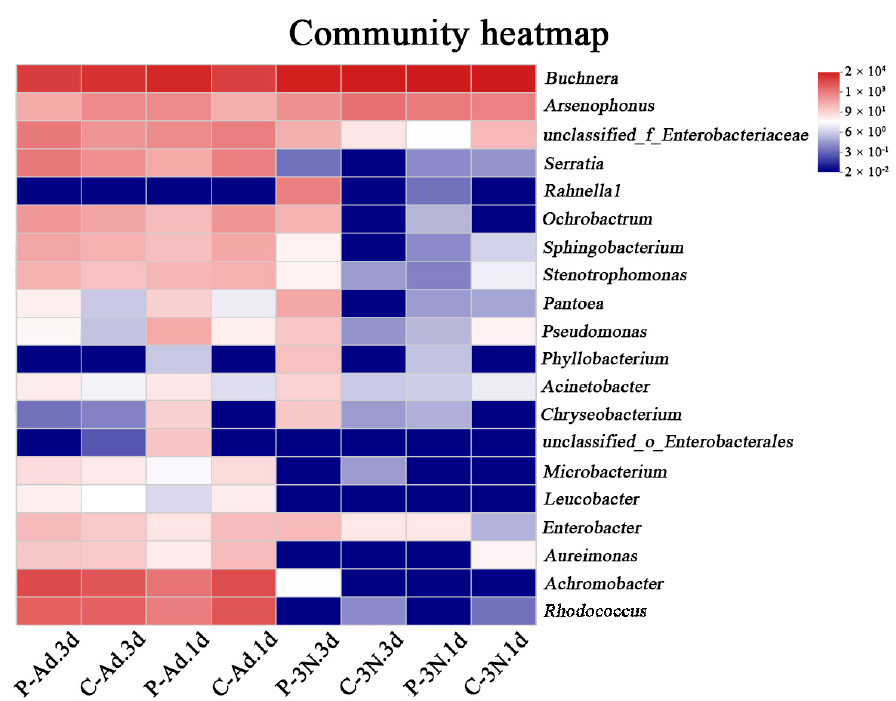
Figure 4. A clustered heat map of the 20 most abundant genera in the bacterial community. The columns represent the different treatments, and the rows represent bacterial genera assigned with ASVs (amplicon sequencing variants). Hierarchical clustering analysis trees of taxonomic genera are shown on the right.